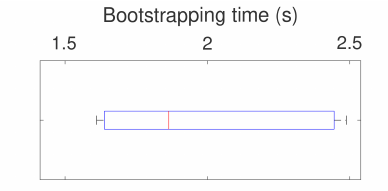
Figure 9. Distribution of time to bootstrap communication with centralized discovery using message update interval of